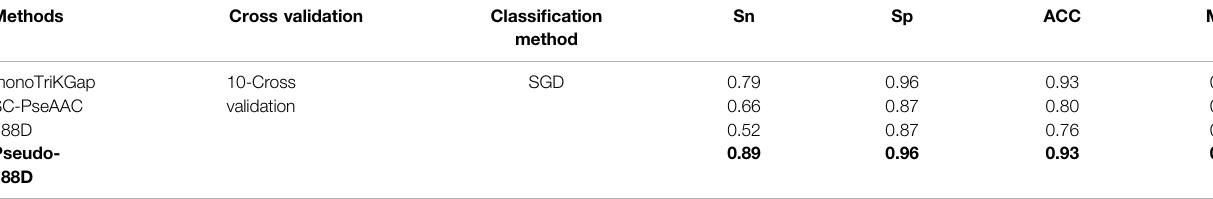
TABLE 1 | Performance comparison of different methods under 10-fold cross-validation.